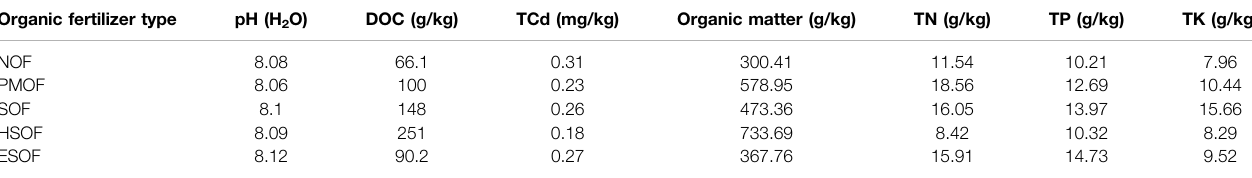
TABLE 1 | Basic physicochemical properties of Manures. Organic fertilizer